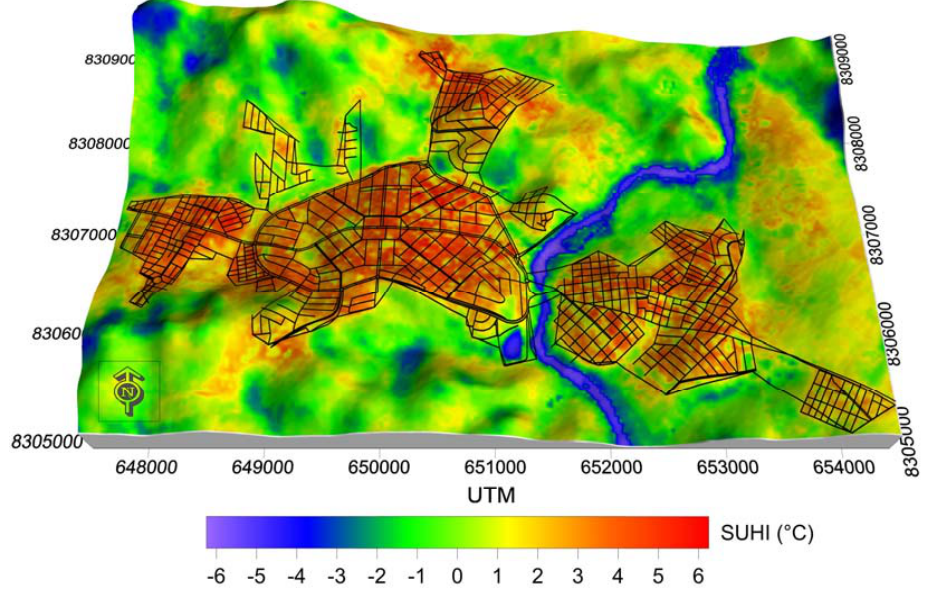
Figure 6. Average SUHIs of the cities of Ceres and Rialma, superimposed on the relief.